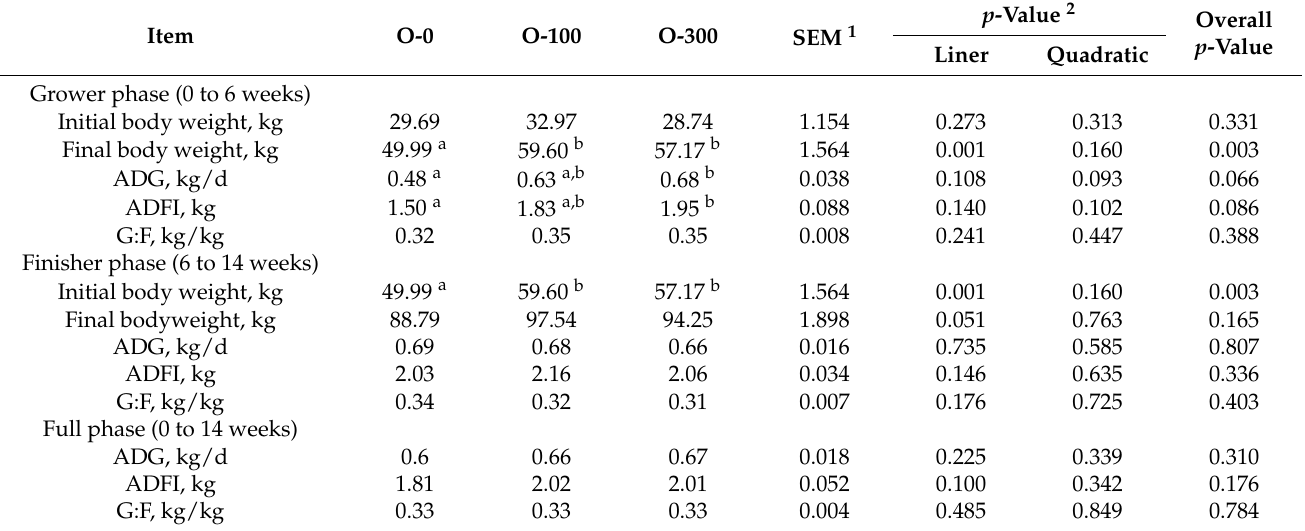
Table 3. The effect of LL supplementation on the growth performance of growing and finishing pigs.